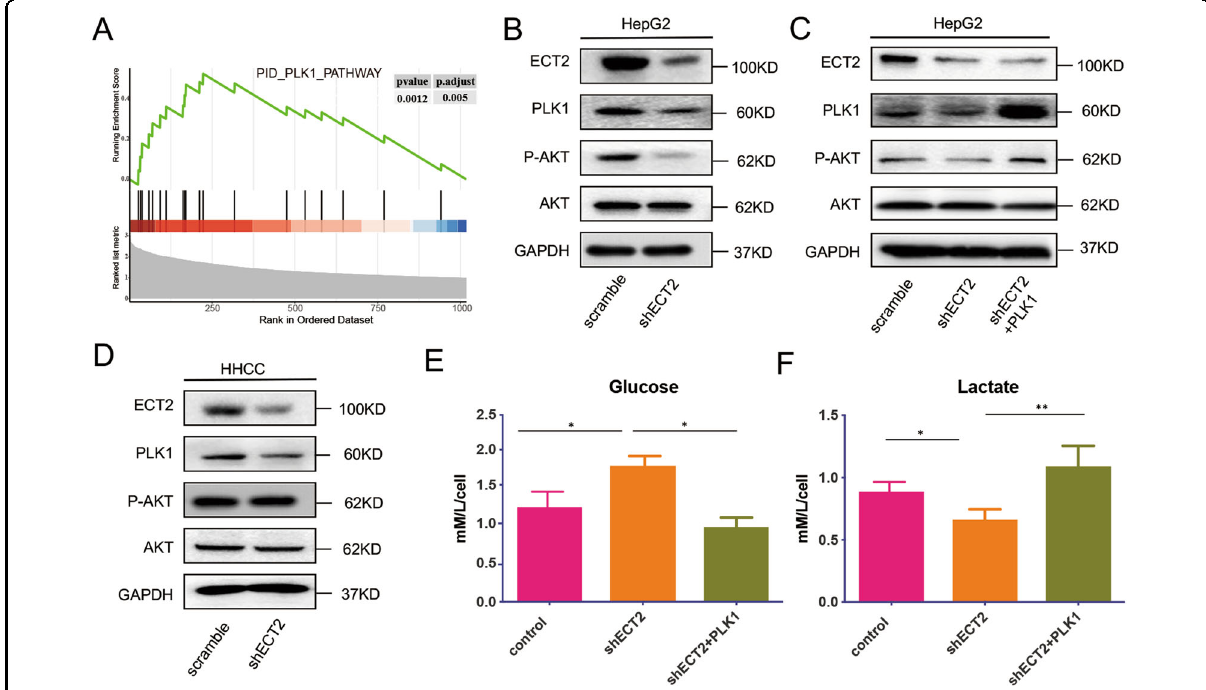
Fig. 4 ECT2 overexpression promotes activation of AKT via the PLK1/PTEN pathway. A Enrichment analysis of ECT2 pathway functions in the TCGA-LIHC cohort. B , C Western blot analysis of p-AKT, PLK1, and AKT expression levels after ECT2 knockdown or PLK1 upregulation in the HepG2 cell line. D Western blot analysis of p-AKT, PLK1, and AKT expression levels after ECT2 knockdown in the PTEN-missing cell line of HCC. E Glucose intake by cancer cells was evaluated after ECT2 knockdown. F Lactate acid production by cancer cells was evaluated after ECT2 knockdown. Error bars represent means ± SD. * p < 0.05, ** p < 0.01. NS means “ not signi fi cant ” by paired two-sided Student ’ s t